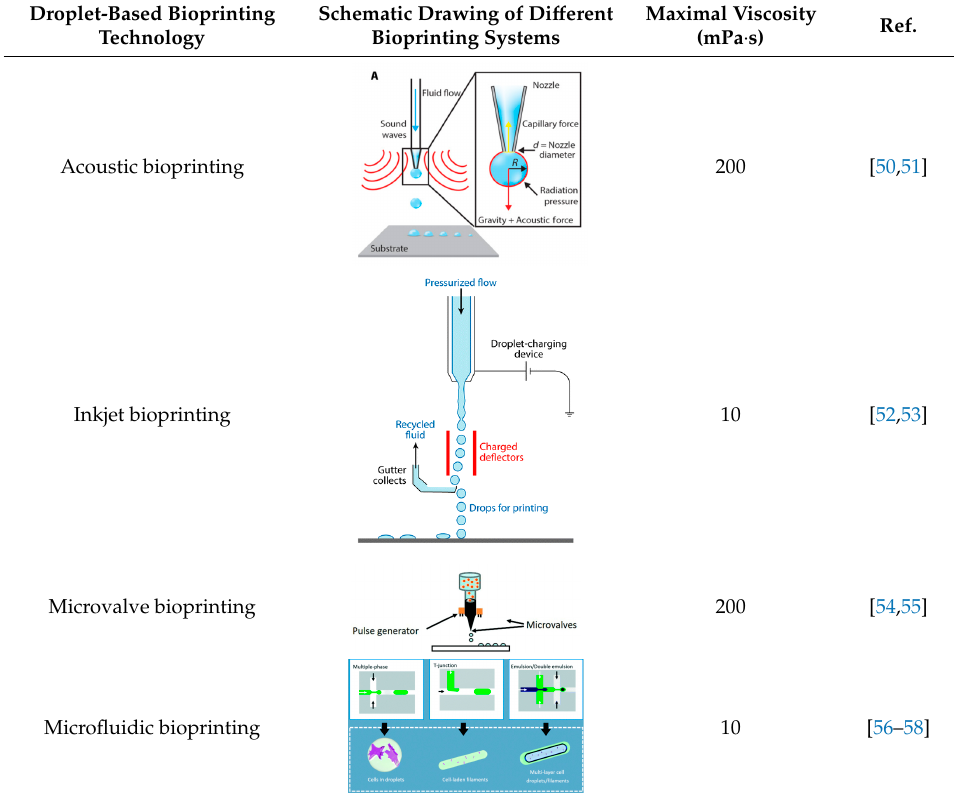
Table 1. Maximal viscosity required by different droplet-based bioprinting technologies.